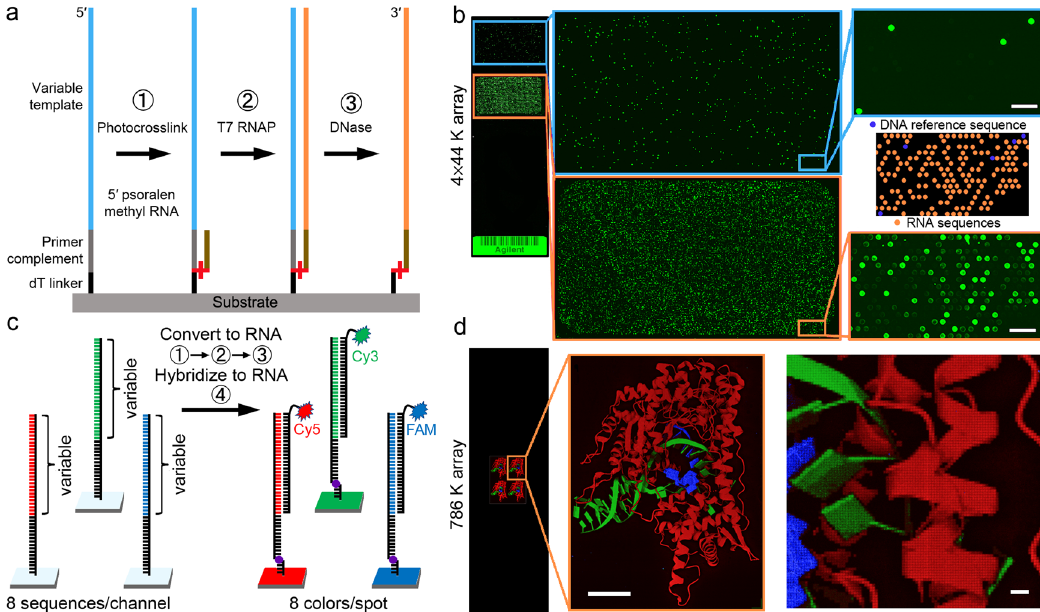
Fig. 1 Enzymatic conversion of DNA microarrays to RNA. a The three-step process of conversion consists of 1- primer hybridization followed by crosslinking, 2- T7 RNA polymerase-mediated RNA extension, and 3- DNase-mediated degradation of the DNA template. b Application of the DNA-to- RNA method to an Agilent SurePrint DNA microarray. The fi rst subarray (outlined in blue) is untreated and hybridized with a 5 ′ Cy3-labeled oligonucleotide, showing the positions of sequences lacking the primer complement section. The second subarray (outlined in orange) has an identical layout but has been converted to RNA, allowing hybridization to surface-bound RNA sequences with the same Cy3-labeled oligonucleotide. Scale bars are 200 µ m. In between the blue and orange-outlined subarray is a schematic illustration of the Agilent microarray layout and the corresponding location of transcribable (orange spots) and untranscribable (blue spots) DNA sequences. c Scheme for creating high complexity, high-resolution RGB images based on hybridization to enzymatically prepared RNA microarrays. Variable lengths of the template sequence served in realization of different shades of each color. d 1024× 768 DNA array synthesized using nucleic acid photolithography such that conversion to RNA and hybridization with Cy3-, Cy5- and fl uorescein-labeled oligonucleotides results in RGB images of the T7 RNA polymerase elongation complex (PDB ID 1MSW [doi.org/10.2210/pdb1MSW/ pdb] 40,56 ). Scale bars in d are 1 mm (left) and 100 µ m